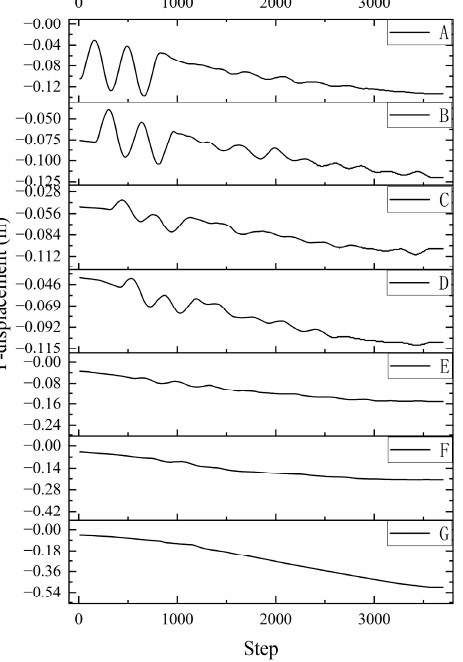
Figure 7. Y − displacement curve of monitoring point.